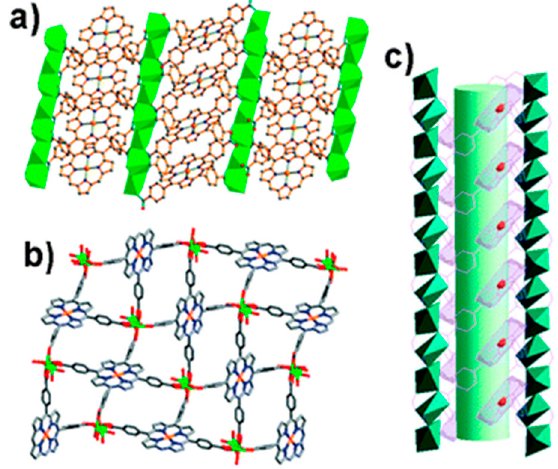
Figure 5. ( a ) Crystal packing of [Cd 1.25 (Pd − H 1.5 T p CPP)-(H 2 O)]·2DMF viewed along the [1,1,0] direction, depicting the arrangement of the palladium-porphyrins; ( b ) Schematic representation of the crystal structure of the material viewed down the [1,0,0] crystallographic direction, emphasizing the 1D opening channels and the accessible Pd II sites; ( c ) Side view of the 1D channel present in this porous framework. Reprinted (“Adapted” or “in part”) from [28] with permission of the PCCP Owner Societies. O O H Catalyst, oxidant + Scheme 4. General scheme of styrene oxidation. It was further demonstrated that the catalytic reaction occurs inside the pores of the material. Remarkably this MOF exhibits better results than those obtained with the metalloporphyrin in homogeneous medium (90% conversion and 78% selectivity for acetophenone) [28]. In the evaluation of the influence of different acids in the oxidation of styrene (Scheme 4), it was observed that acetic acid did not boost the catalytic transformation, while hydrochloric acid